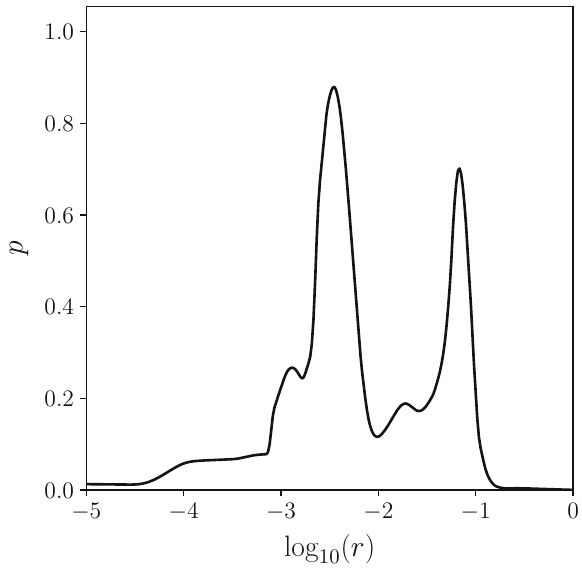
Fig. 3 Posterior distribution on the tensor-to-scalar ratio r , averaged over all physical single-field models of inflation as listed in Ref. [32] (where each model is weighted by its Bayesian evidence), using the Planck 2013 data and the results of Ref. [33]